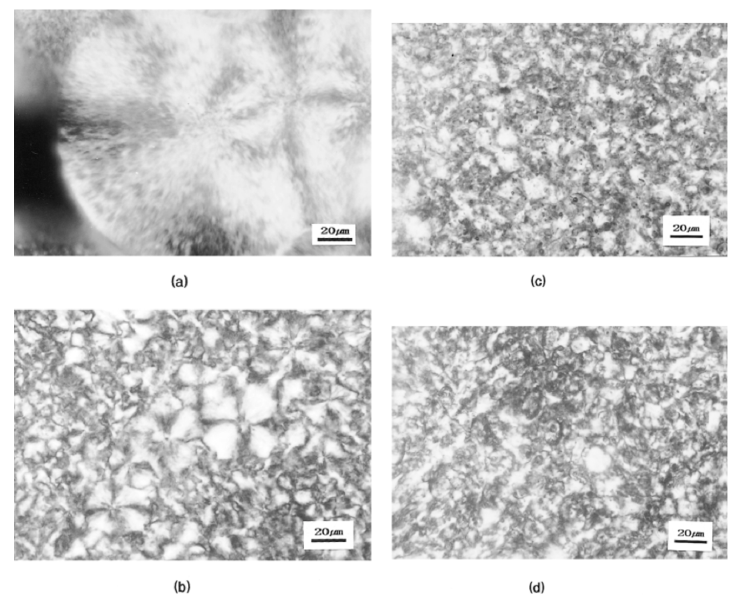
Figure 5. Polarized optical micrographs of PLA and PLA / PBS blends, isothermally crystallized at 100 ◦ C for 12 h: ( a ) 100 / 0; ( b ) 90 / 10; ( c ) 80 / 20; ( d ) 70 / 30 [25]. Reprinted from Journal of Applied Polymer Science, Volume 86, Park, J.W.; Im, S.S., Phase behavior and morphology in blends of poly(L-lactic acid)